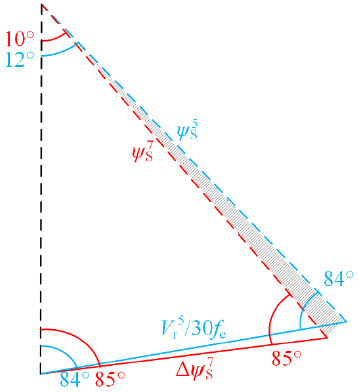
Figure 6. Flux trajectories Change rate of SSVM_7 and SSVM_5. According to the flux trajectories of SSVM_7 and SSVM_5 shown in Figure 6, the stator flux vector ψ 7 of SSVM_7 rotates 10 ◦ in each sub-cycle, and the reference voltage S phase angle changes from 5 ◦ to 15 ◦ . The stator flux vector ψ 5 of SSVM_5 rotates 12 ◦ in S each sub-cycle, and the reference voltage phase angle changes from 6 ◦ to 18 ◦ . Due to the different flux trajectories change rate, the angle of flux vector rotation is different at the end of the reference voltage vector action, resulting in angle deviation, such as the